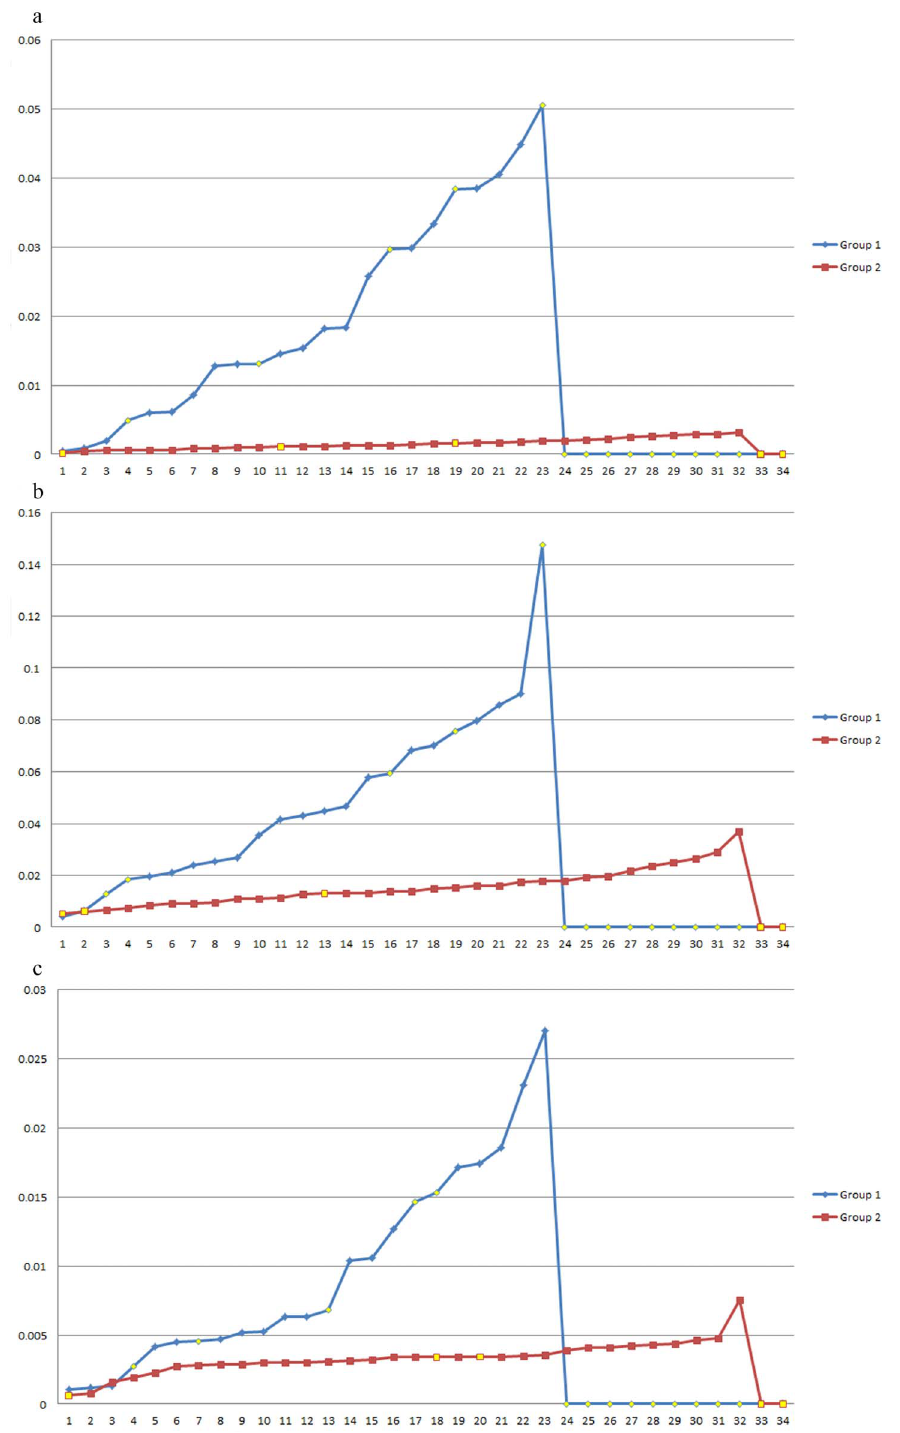
Figure 4. Line charts of variances of base distance, codon distance, and amino acid distance for phylum-divided groups and genomic GC content-divided groups. Group 1: the data were divided based on phylum; Group 2: the data were divided based on genomic GC content. a) Y: Base distance variances; X: sections. b) Y: Codon distance variances; X: sections. c) Y: Amino acid distance variances; X: sections. doi:10.1371/journal.pone.0107319.g004 variances in Group 1 and Group 2 range from 0.004812 to Fig. 4 shows that the base distance variances of Group 1 vary 0.147581 and from 0.005235 to 0.036949, and the amino acid widely from 0.000477 to 0.050552. Compared with Group 1, the distance variances of the two groups are from 0.001018 to base distance variances of Group 2 range within a smaller scale 0.027048 and from 0.000627 to 0.007536, respectively. Never- from 0.000169 to 0.003120. Additionally, the codon distance